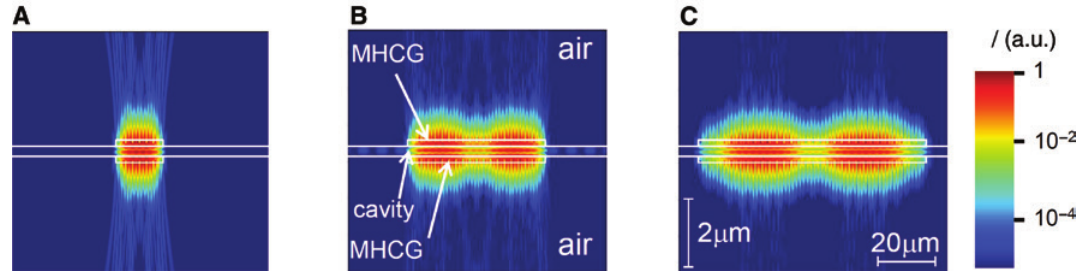
Figure 7: Cross-sectional distributions of normalized light intensity of the fundamental mode in M-M microcavities in the yz -plane for MHCGs with the following numbers of stripes: (A) 20, (B) 60, and (C) 100. The positions of the MHCG and microcavity are indicated. The parameters of the MHCG are our standard LFH = 273 nm. and d c